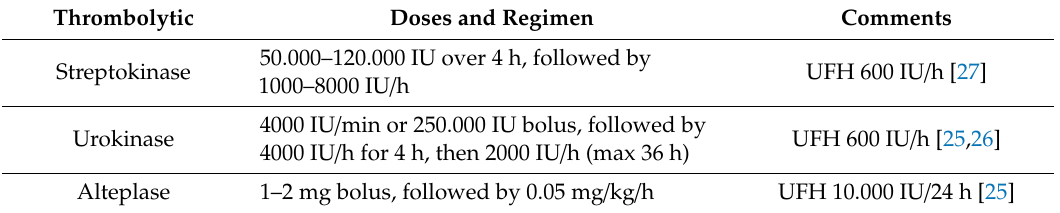
Table 2. Intra-arterial thrombolytic therapy and approved regimens in ALI.